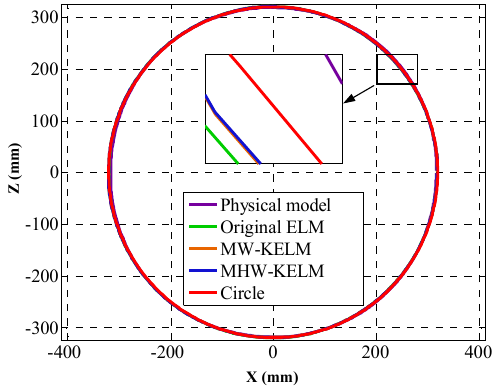
Figure 8. Calibrated circle.